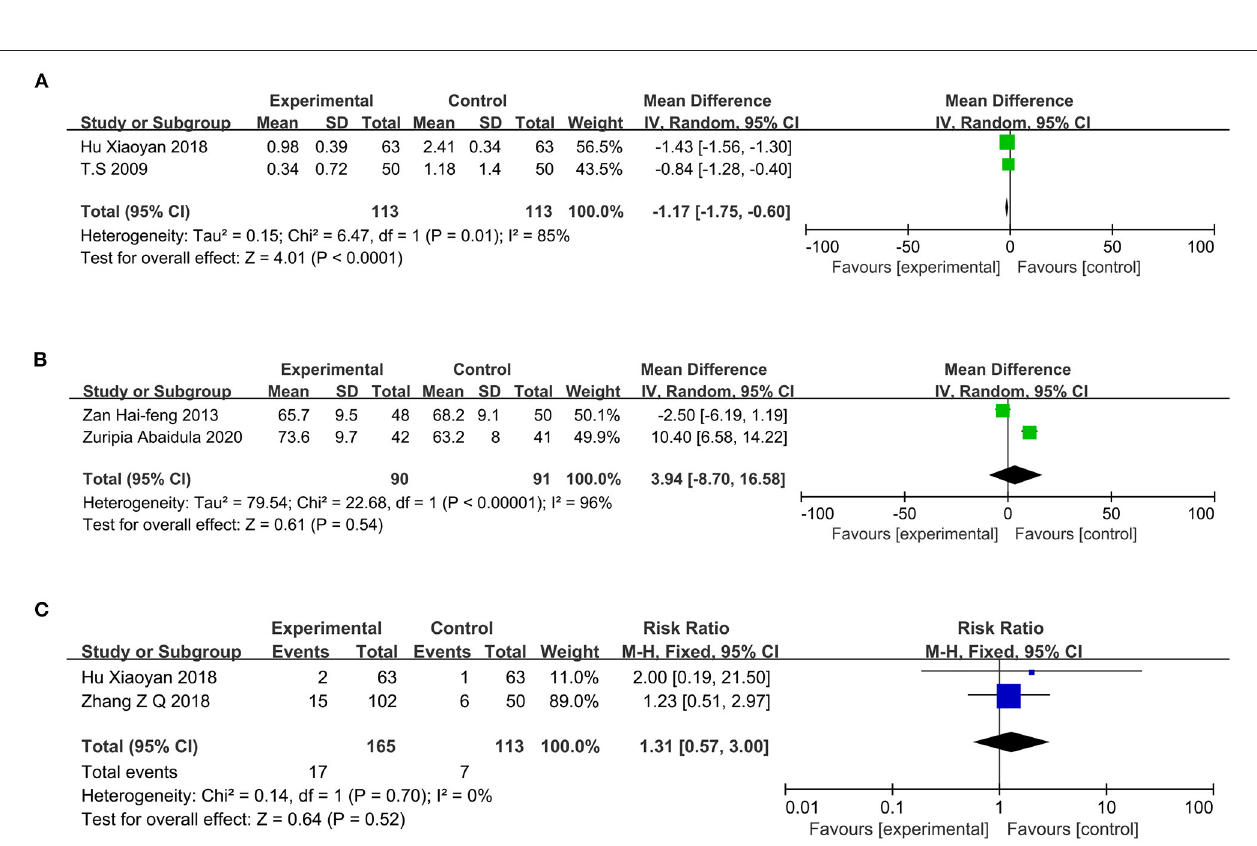
FIGURE 7 | (A) Forest plot of the number of acute exacerbations between the PPI treatment and conventional treatment groups; (B) Forest plot of FEV1/FVC between the PPI treatment and conventional treatment groups; (C) Forest plot of nosocomial infection rate between the PPI treatment and conventional treatment groups. FEV1/FVC, forced expiratory volume in 1 s/forced vital capacity; PPI, proton-pump inhibitor.